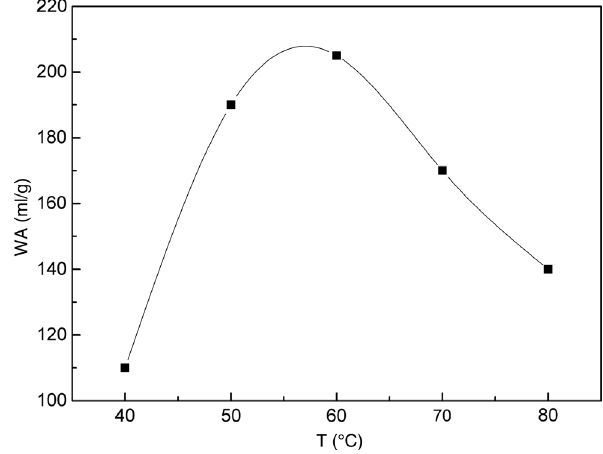
Figure 1 Effect of reaction temperature on